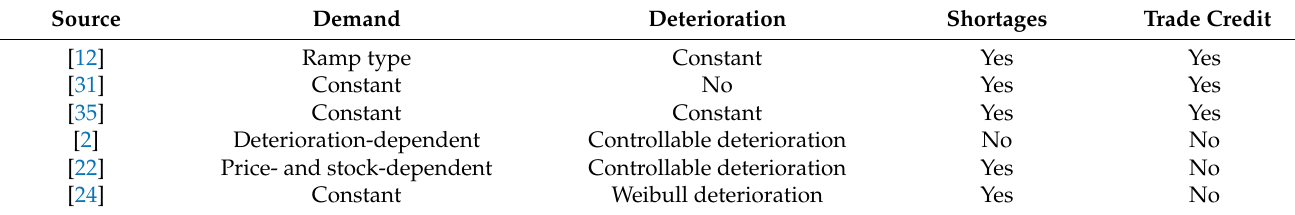
Table 1. An overview of similar studies on the EOQ